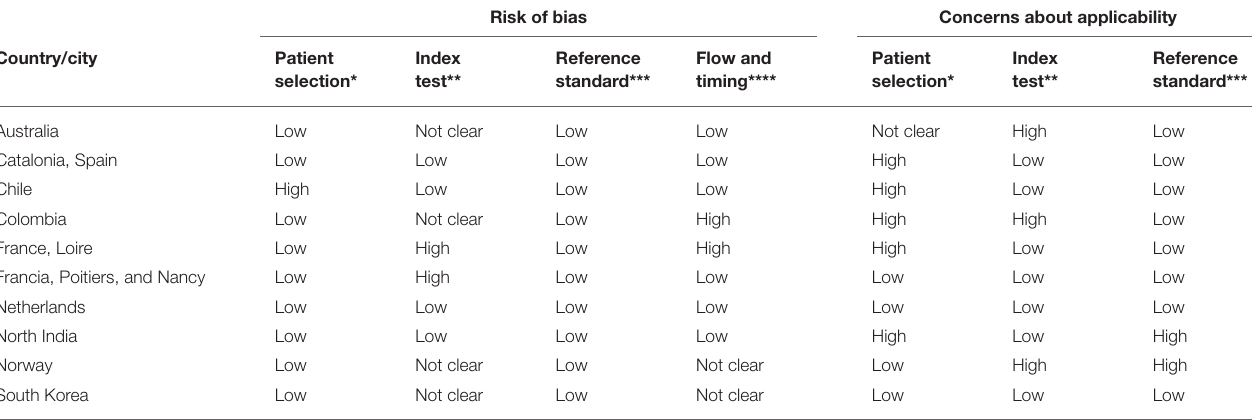
TABLE 3 | Risk of bias and concerns about